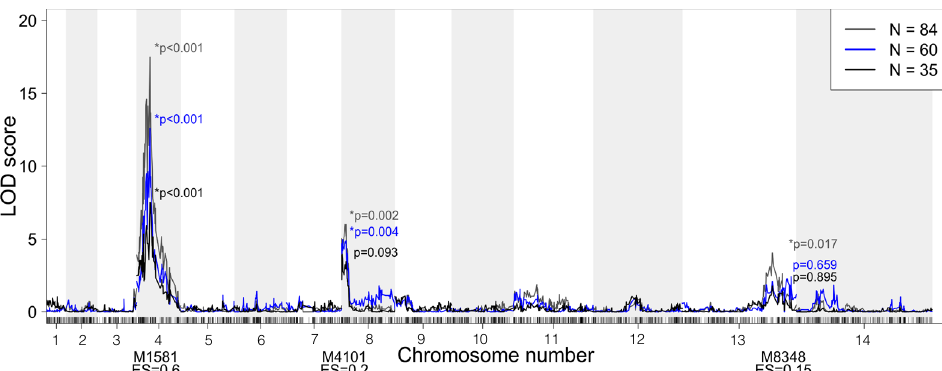
Fig. 6 Detecting complex associations. QTL scans of simulated phenotypes with one major (ES = 0.6) and two minor (ES = 0.2 and 0.15) contributing loci for N = 84 (gray), 60 (blue) and 35 progeny (black). The major locus is detected for all sizes of N , but only one minor locus is detected for N = 60 progeny and neither minor locus is detected at N = 35